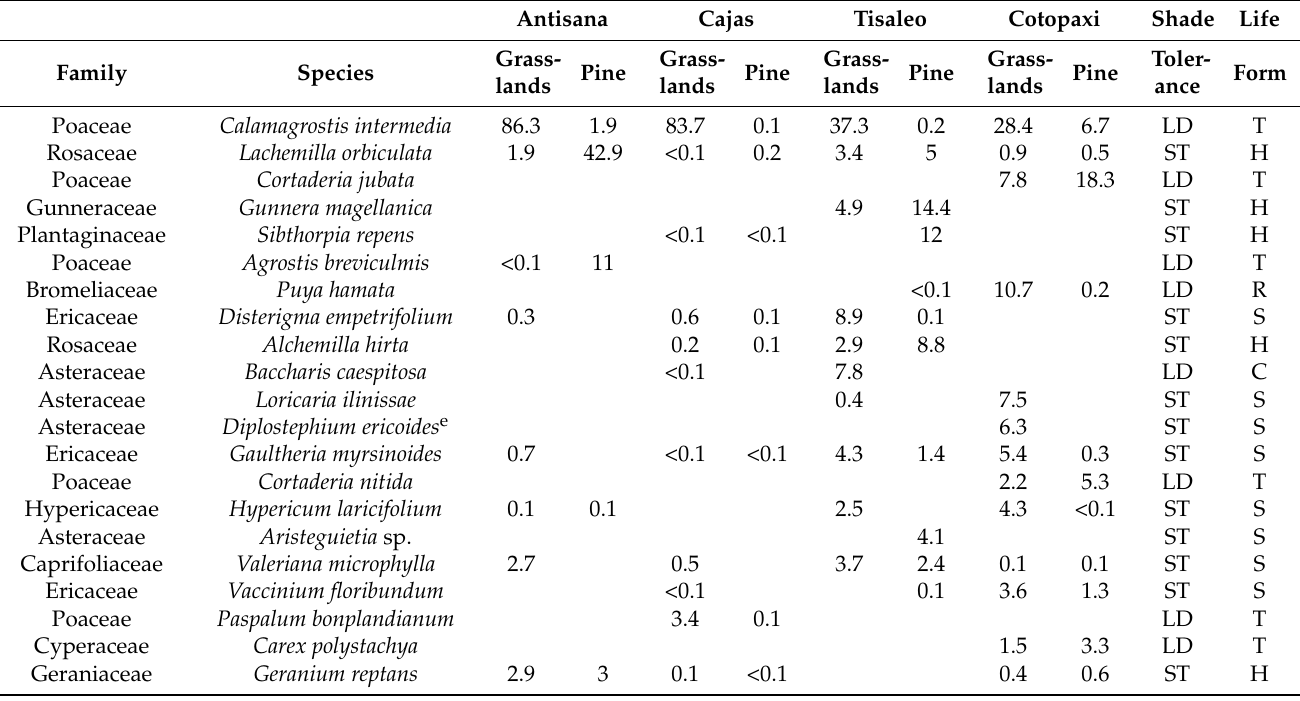
Table A1. Plant cover (%) of species in P á ramo grasslands and under pine plantations in Antisana, Cajas, Tisaleo and